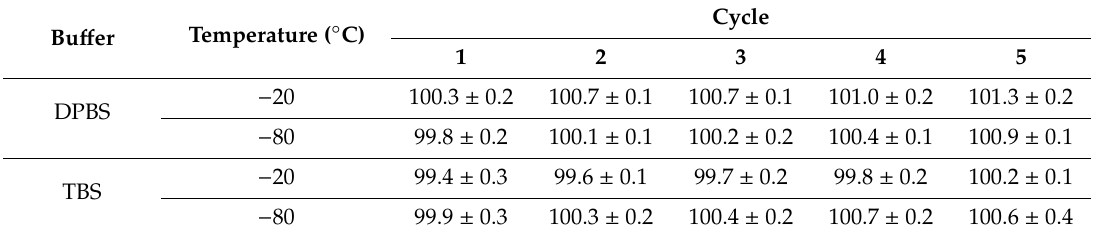
Table 4. Recovery of CSP7 acetate in bulk solution after multiple freeze-thaw cycles.